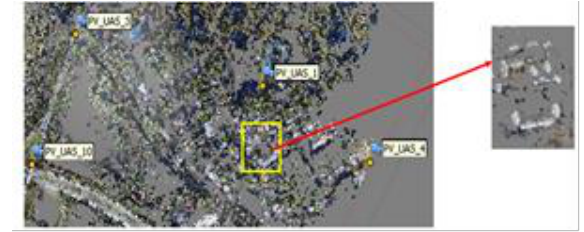
Figure 2. Point cloud model created by SfM